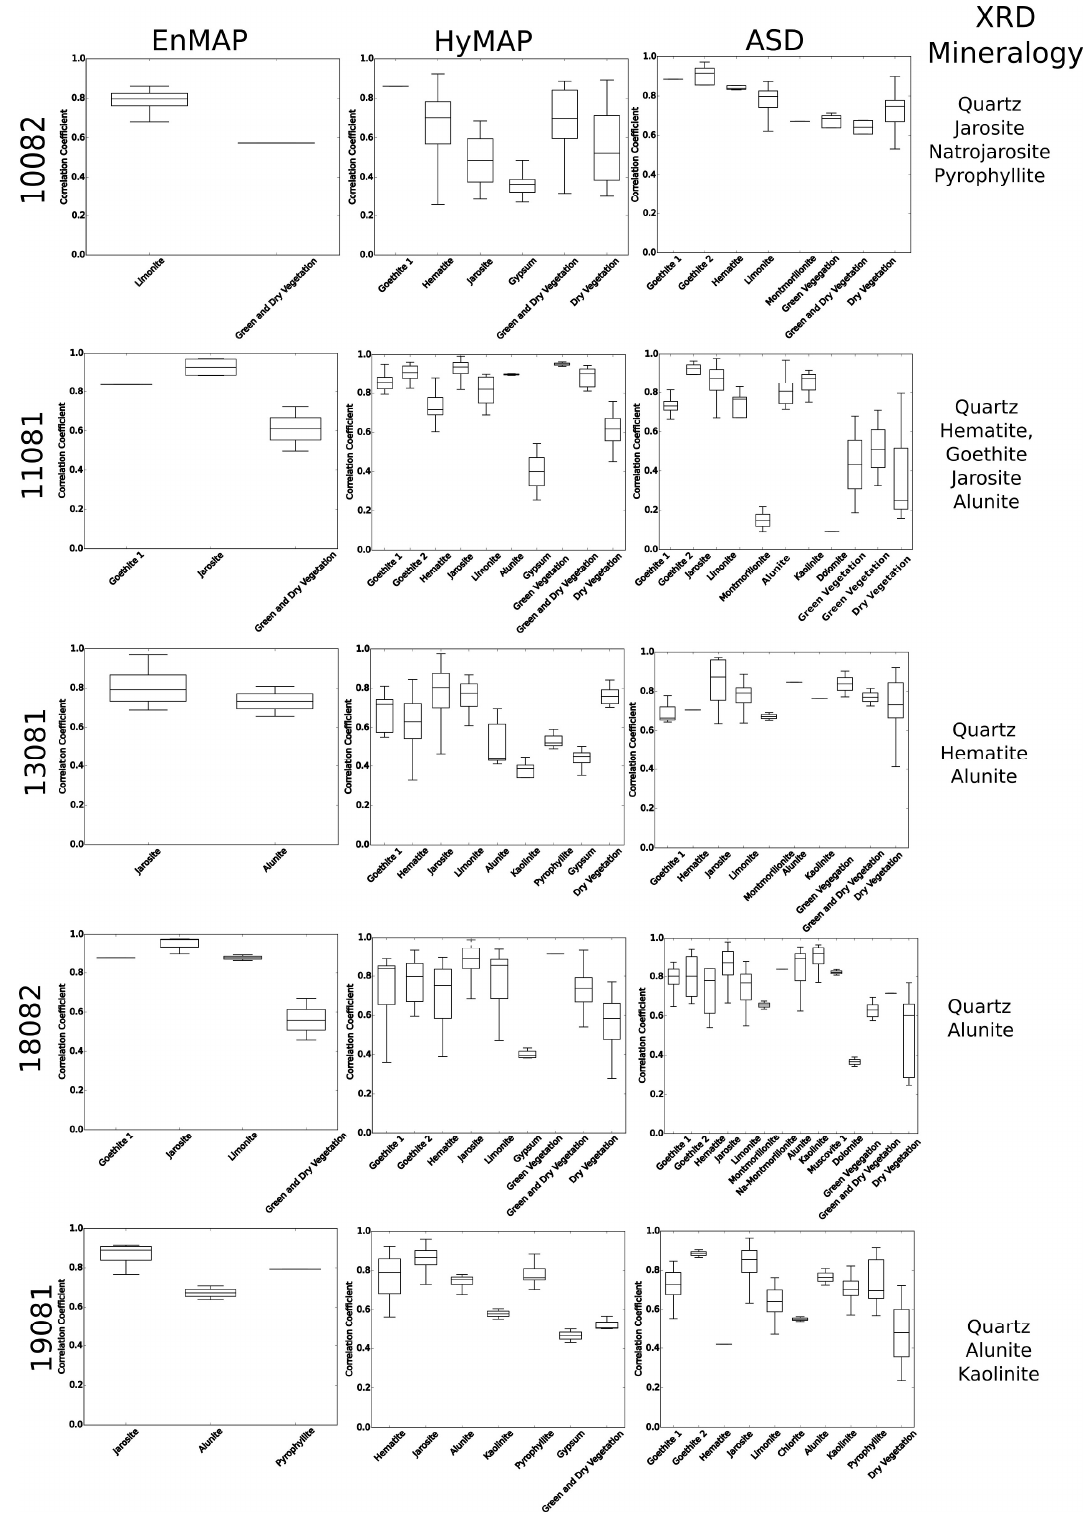
Figure 21. Boxplots showing the linear correlation values of the EnGeoMAP 2.0 detected materials at field validation sites from the Rodalquilar area from simulated EnMAP data, HyMAP data and ASD field spectra together with analysis results from XRD data.